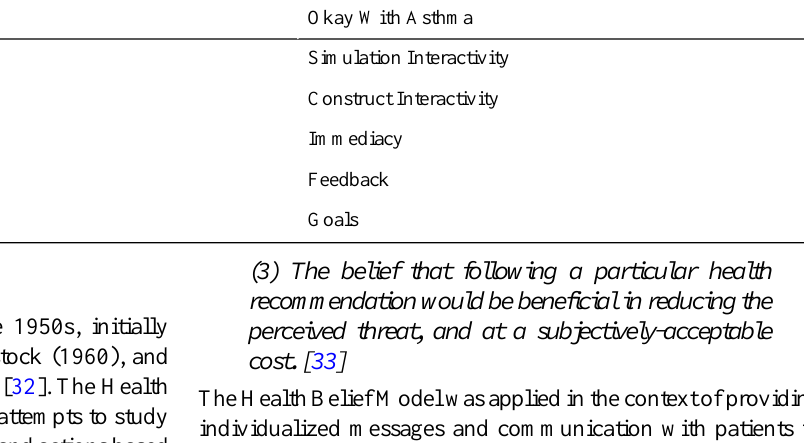
Okay With AsthmaWDTA